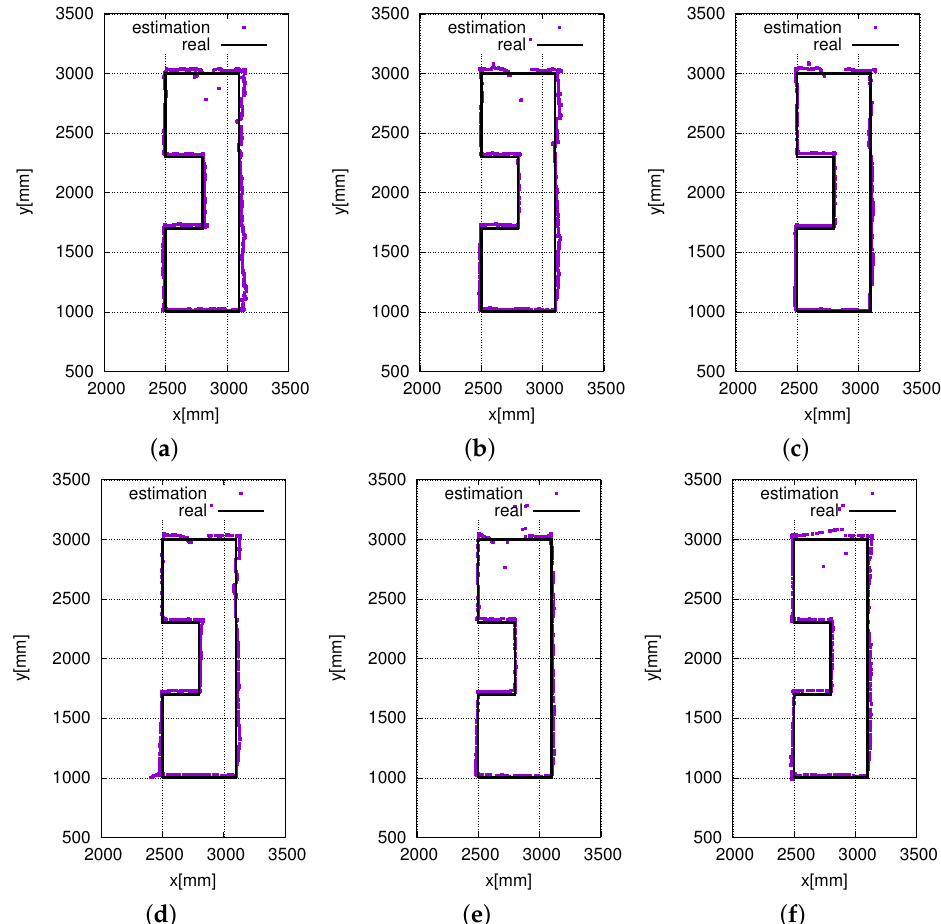
Figure 15. Real-time self-localization trajectories at different speeds. ( a ) 50 mm/s; ( b ) 150 mm/s; ( c ) 200 mm/s; ( d ) 250 mm/s; ( e ) 300 mm/s; ( f ) 350